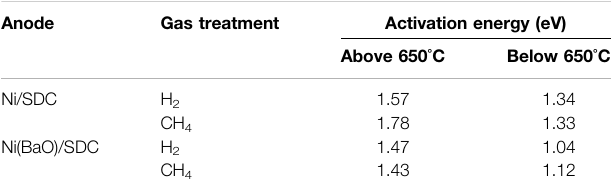
TABLE 1 | Activation energies of electric conduction of the anode fi lms formed on the comb-type Au electrode. The values were evaluated from the temperature-dependent resistance in Ar subsequently to the H 2 or 2% CH 4 /Ar exposure. Anode Gas treatment